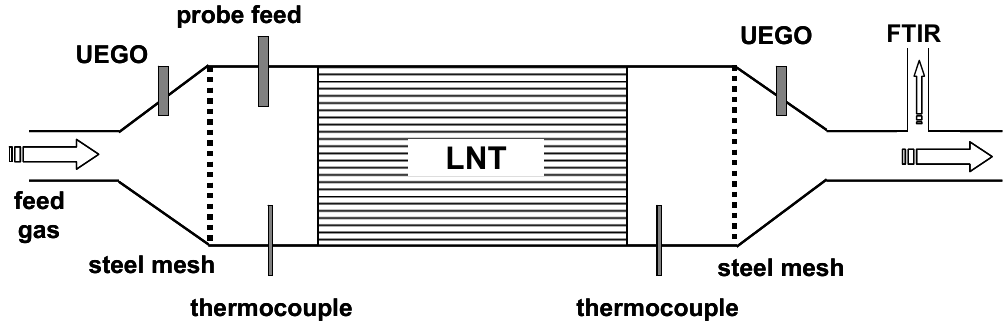
Figure 1. Schematic test setup for the microwave-based